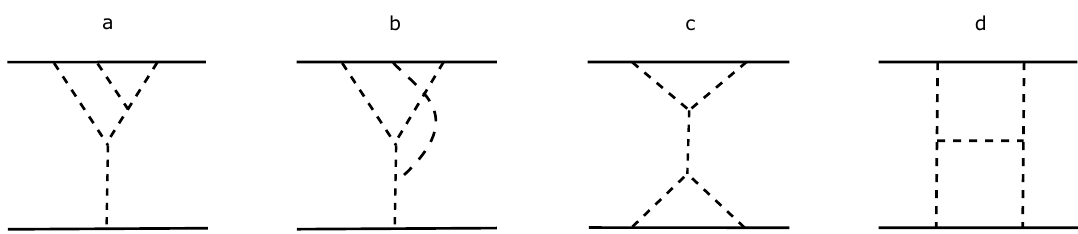
Figure 2 . Graphs contributing at order Gr 6 . Graphs a and b are the double triangle graphs, graph V c is the triangle squared, and graph d is the H type. For each graph we include the inequivalent permutations of external legs. The number of different labelings of the external legs that are considered are 4 for graph a, 2 for graph b, 1 for graph c, and 2 for graph